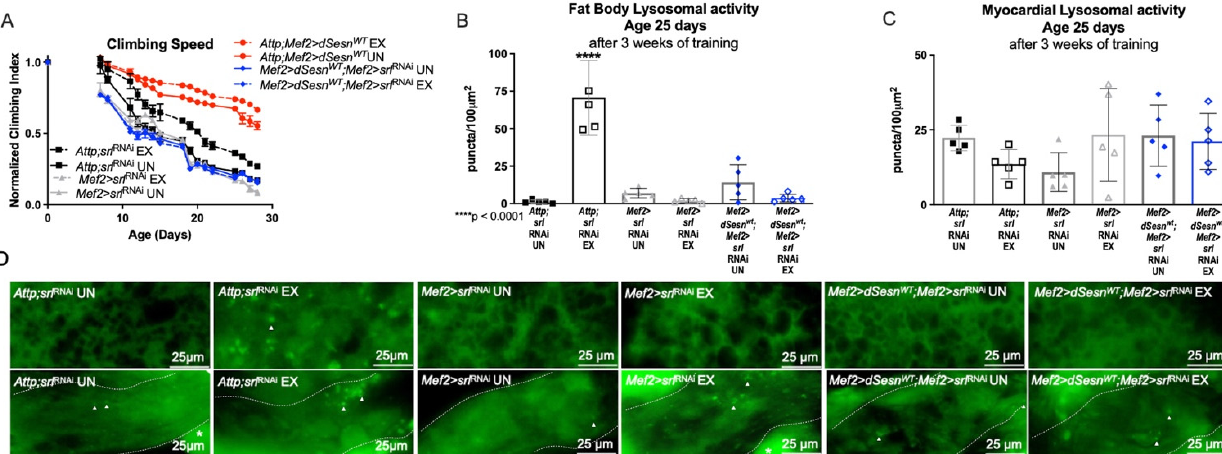
Figure 7. PGC1 α is required for exercise- and Sestrin-dependent adaptations to climbing speed and lysosomal activity. ( A ) Flies expressing RNAi against PGC1 α in muscles have a climbing speed similar to unexercised background controls independent of both dSesn expression and exercise ( Mef2 > srl RNAi flies, Mef2 > dSesn WT ; Mef2 > srl RNAi flies, 2-way ANOVA, p ≥ 0.2168). Climbing speed experiments performed in duplicate, n ≥ 100 flies. ( B ) Mef2 > dSesn WT ; Mef2 > srl RNAi flies have low fat body Lysotracker staining whether exercised or not. ( C ) Myocardial Lysotracker staining is similar across genotypes independent of exercise and wild-type dSesn expression. ( D ) Representative 63× images of Lysotracker staining in fat body (upper panels) and myocardium (lower panels) of exercised and control flies expressing muscle-specific RNAi against PGC1 α . Lysotracker staining n = 5, performed in triplicate. Dotted lines in myocardial images delineate heart tissue. White triangles point to example regions of Lysotracker puncta. White asterisks indicate pericardial cells. Error bars depict ± SD. EX = cohort after 3 weeks of ramped, daily endurance training. UN = control unexercised flies exposed to an identical training environment without running.